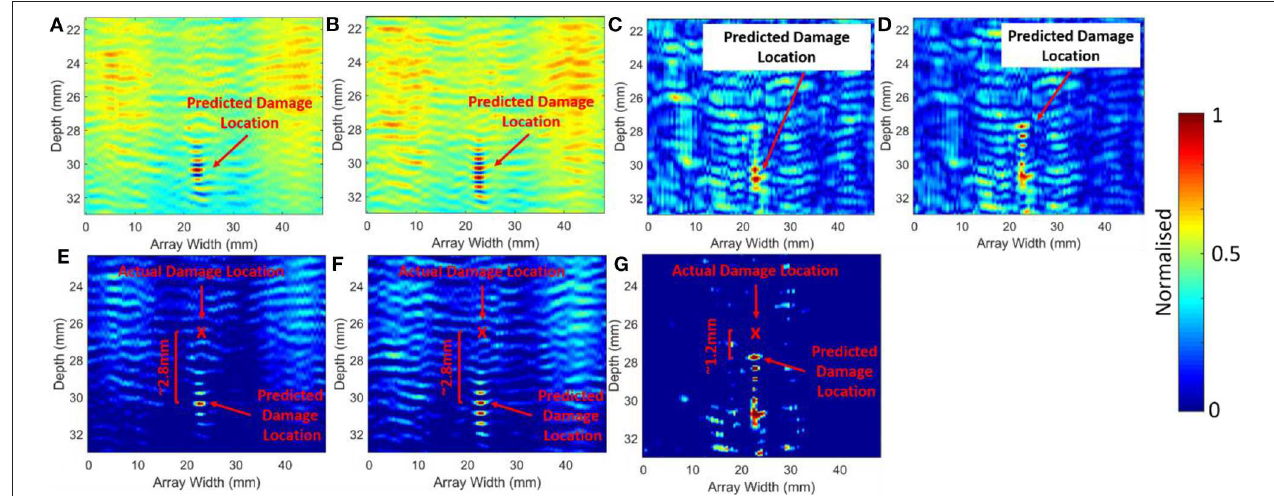
FIGURE 9 | LFC sample comparison between linear vs. non-linear results: (A) f 1 ; (B) f 2 ; (C) M R 2 ; (D) β S + D , and 50% threshold of LFC sample comparison of linear comparison between linear vs. non-linear results: (E) f 1 ; (F) f 2 ; (G) β S + D .